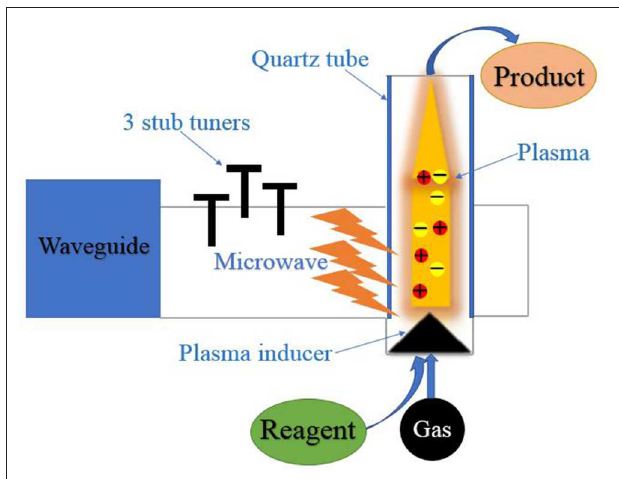
SCHEME 2 | The schematic diagram of the microwave-induced plasma catalysis.